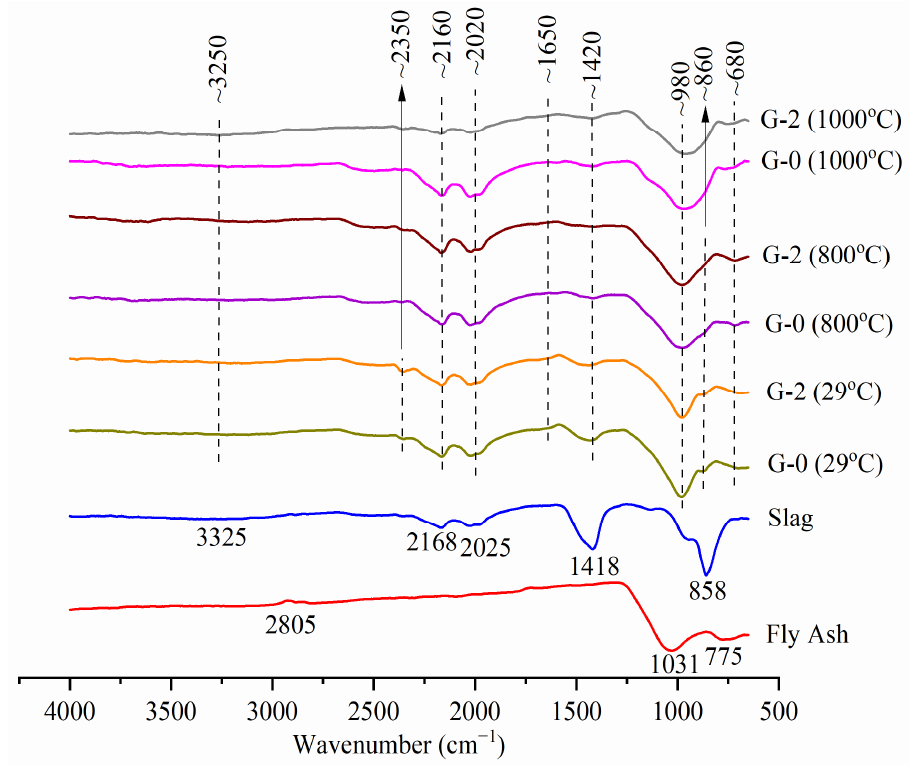
Figure 13. IR spectra of fly ash, slag, unexposed and temperature-exposed G-0 and G-2.